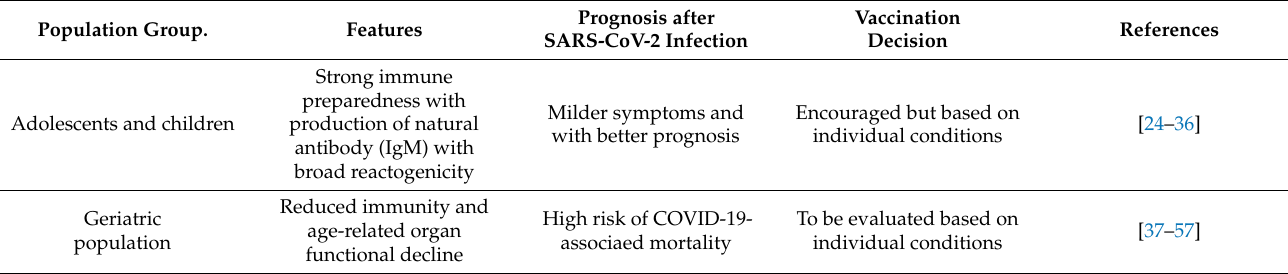
Table 4. Summary table for vaccination decision making in different population groups. Population